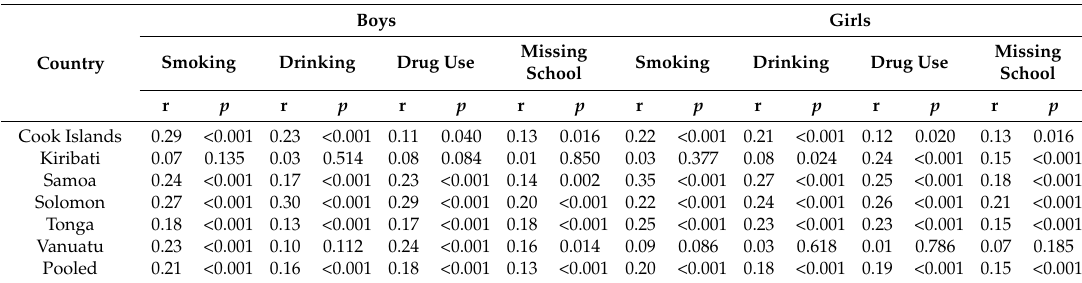
Table 3. Age-adjusted partial correlation coefficients of physical fighting with smoking, drinking, drug use and missing school in young adolescents in 6 Western Pacific